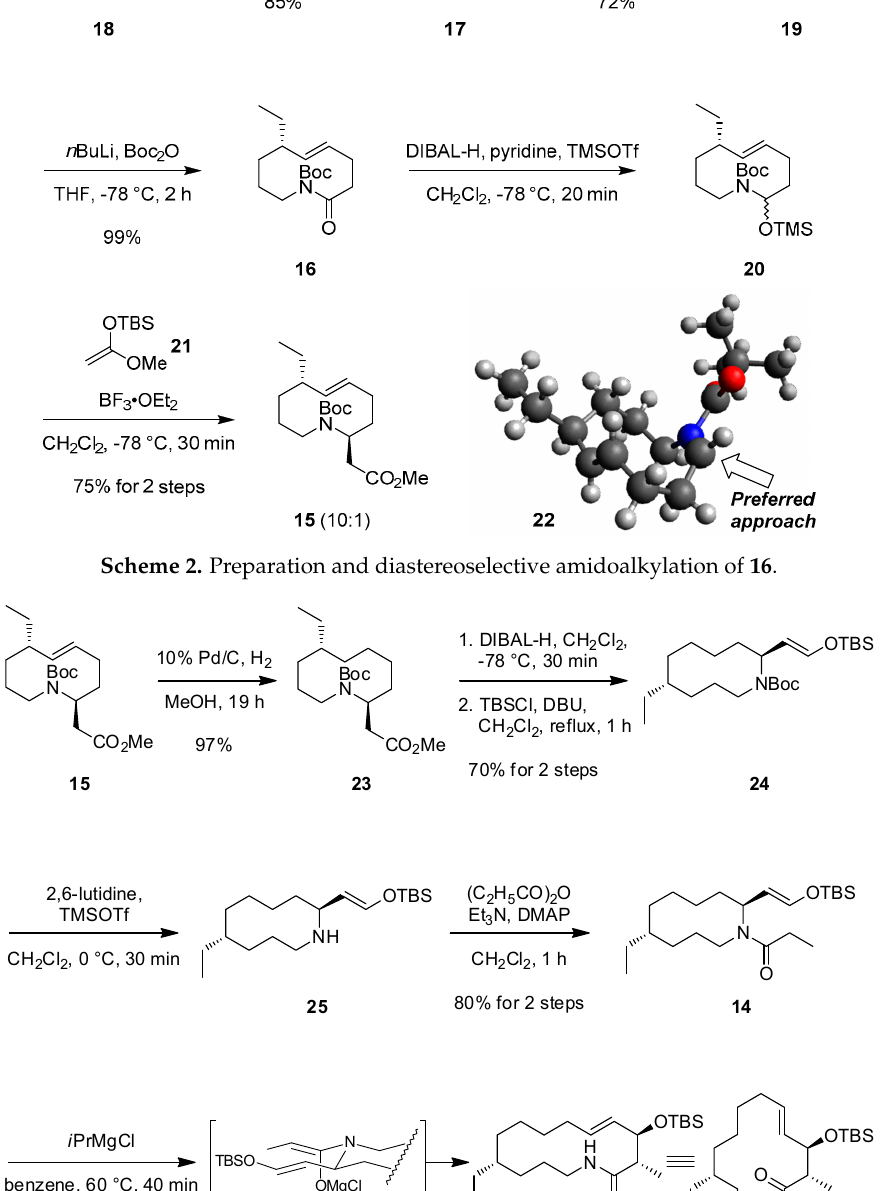
Figure 3. X-ray crystallographic structure of 32 . Displacement ellipsoids are drawn at the 50% probability level and H atoms are shown as small spheres of arbitrary radii; black = carbon, red = oxygen, blue = nitrogen, and yellow = silicon. For the completion of the synthesis, macrolactam 26 was hydrogenated and then desilylated to produce 14 with a 99% yield for two steps (Scheme 4). O NH OTBS TBAF THF, 1 h 99% for 2 steps O NH OH 13 (-)-6-Desmethyl-fluvirucinine A 1 O NH OTBS10% Pd/C, H 2 MeOH/EtOAc (1:1), 12 h 26 27 Scheme 4. Completion of the ( − )-6-demethyl-fluvirucinine A 1 ( 13 ) synthesis.